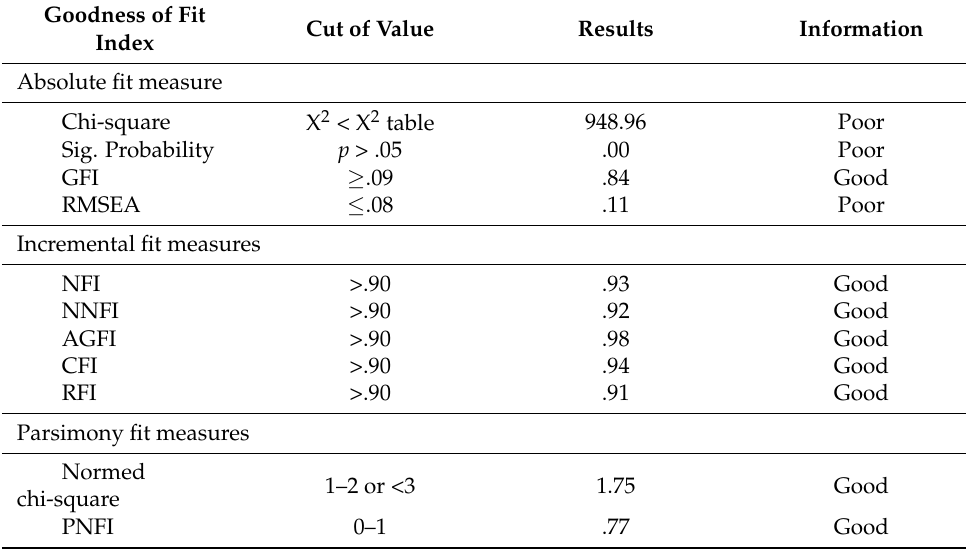
Table 4. Goodness-of-fit statistics.